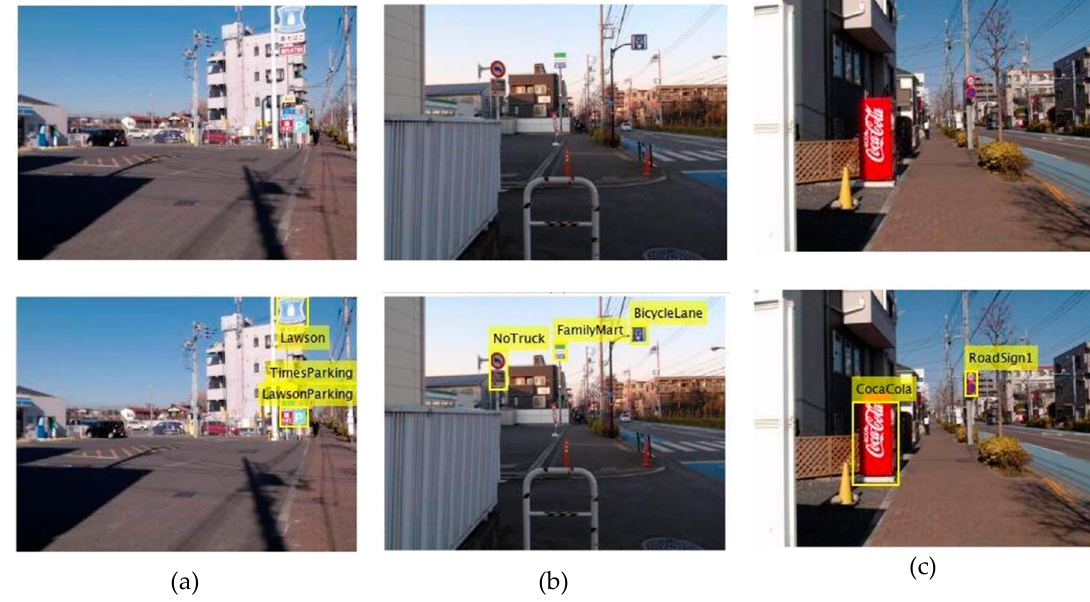
Figure 8. Samples of images in the test set and the Faster R-CNN landmark detection results: ( a ) Sample 1; ( b ) Sample 2; ( c ) Sample 3. Table 1. Average precision values of detection results from Faster R-CNN, with 0.5 and 0.7 intersection over union (IoU).